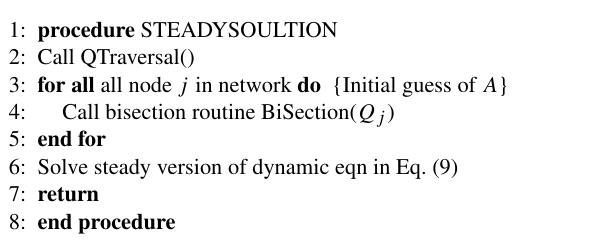
Algorithm 3 Steady-solution